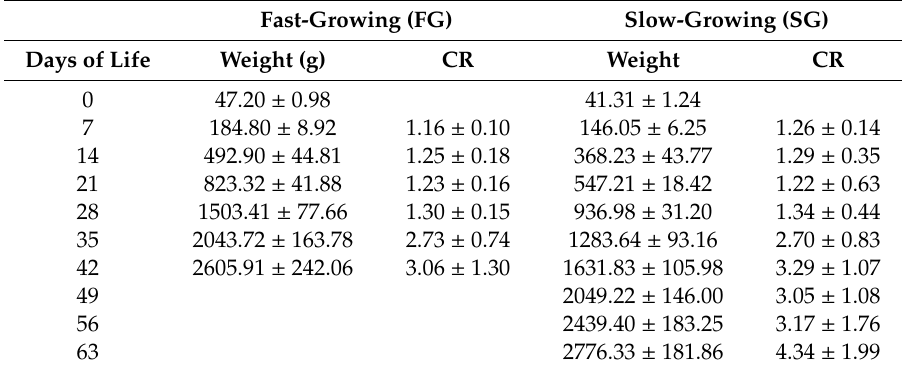
Table 2. Weight of the animals (weight ± s.d) and conversion rate (CR ± s.d.) during the productive cycle for fast (FG) and slow-growing (SG) management